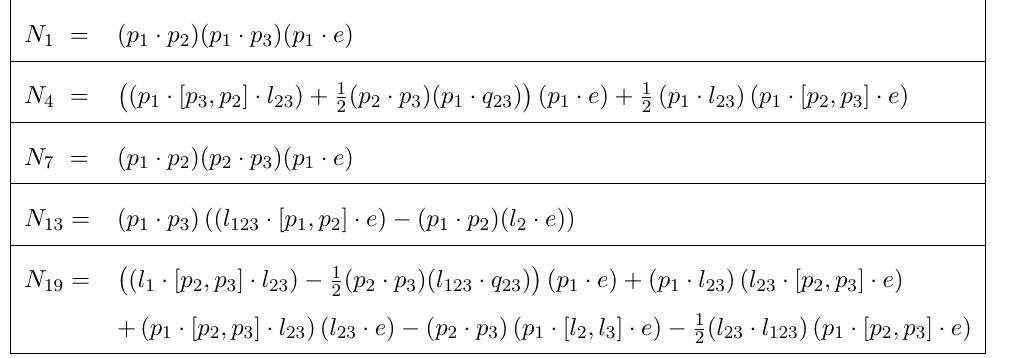
Table 2 . An particular example of duality-satisfying representations where e (cid:22) is the YM polar- ization and q (cid:22) = l (cid:22) (cid:0) l (cid:22) . We de(cid:12)ne the tensor [ a; b ] (cid:22)(cid:23) = a (cid:22) b (cid:23) (cid:0) b (cid:22) a (cid:23) such that p (cid:1) [ a; b ] (cid:1) q = 23 2 3 ( p (cid:1) a )( b (cid:1) q ) (cid:0) ( p (cid:1) b )( a (cid:1) q ). All other numerators are related by